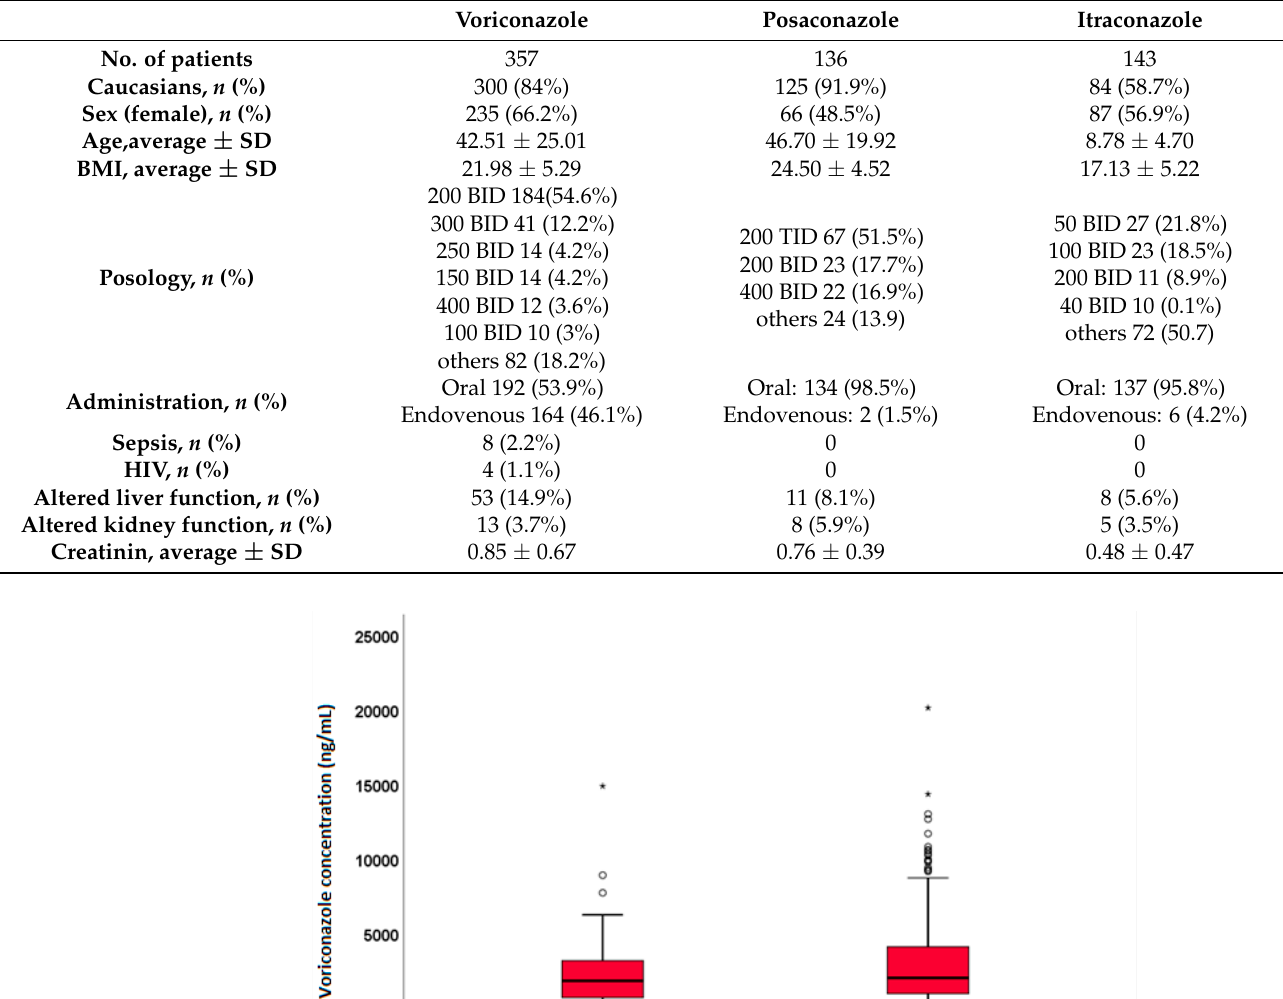
Table 1. Characteristics of subjects involved in the study.